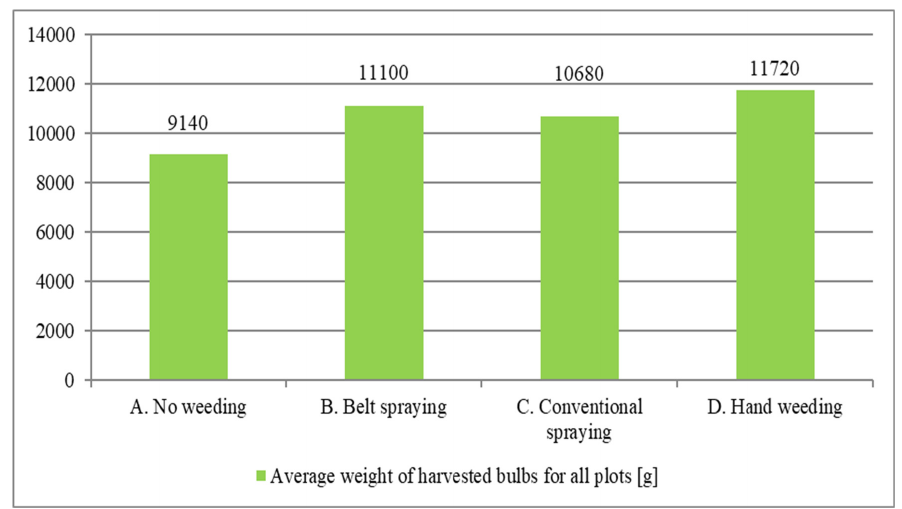
Figure 8. Average onion yield per plot for individual weeding methods.